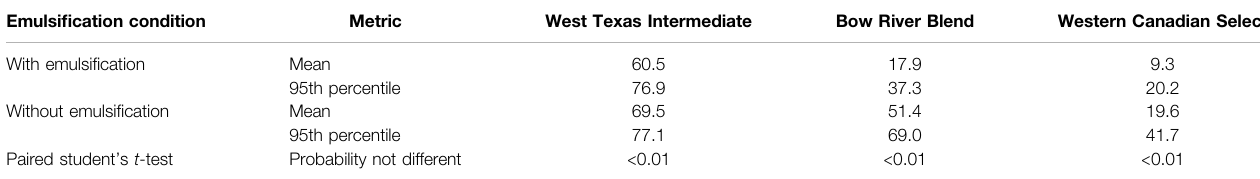
TABLE 7 | Percentage ultimately degraded or dispersed in the water column after a 200-MT spill, based on results for 114 simulations varying spill date. Emulsi fi cation